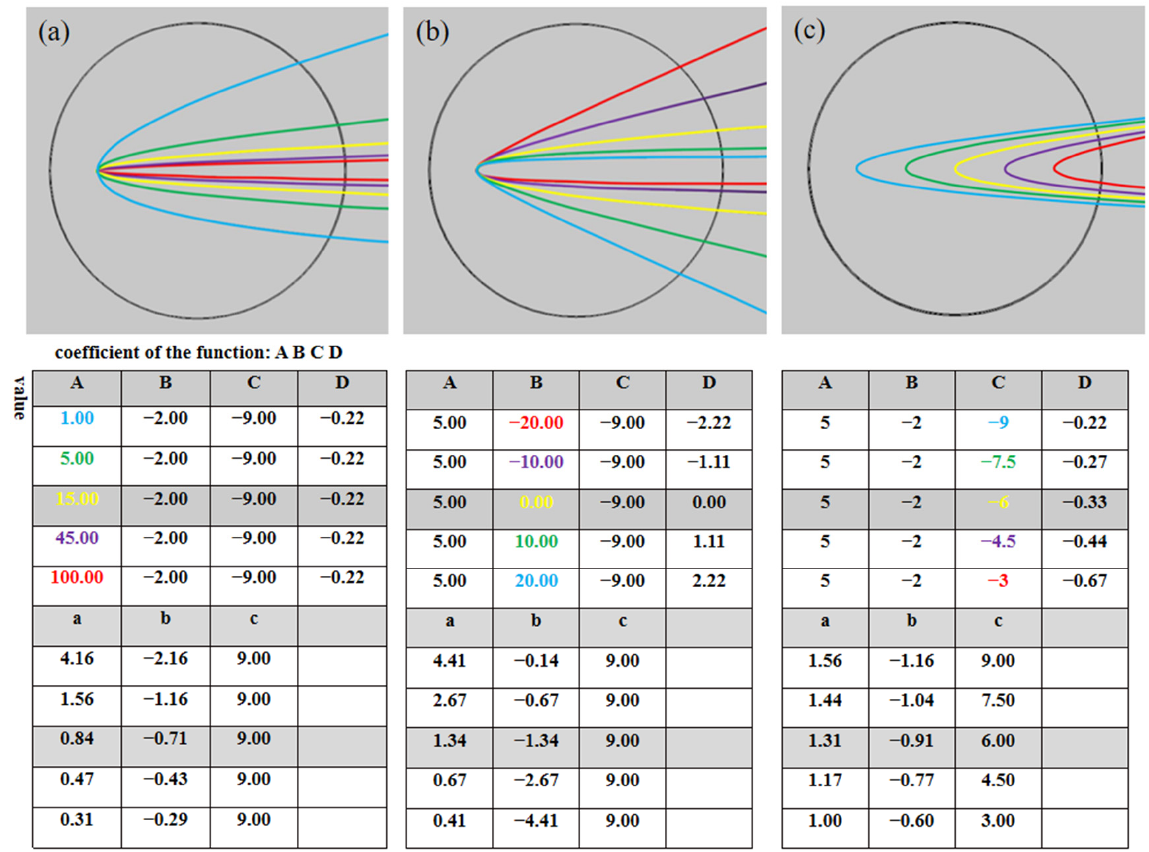
Figure 6. Regulation coefficient A , B , and C control a , b , and c ( M , N , and P ). ( a ) Change A . ( b ) Change B . ( c ) Change C .